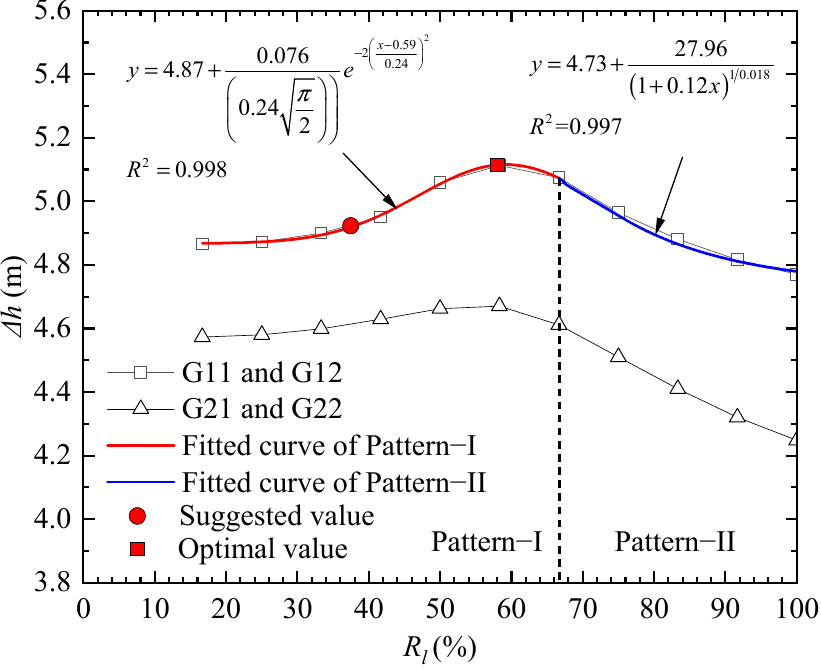
Figure 12. Relationship between R l and Δ h.